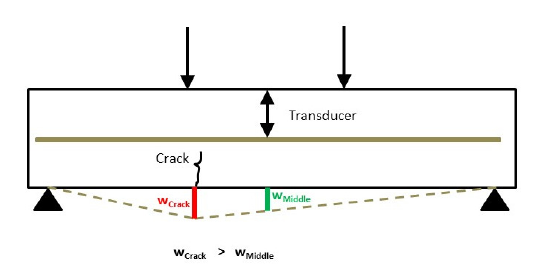
Figure 3. Calculation approach for taking the point of crack into account using the theorem of intersecting lines